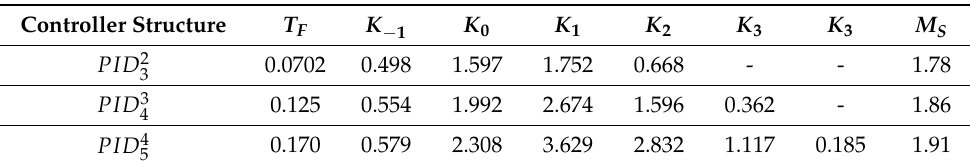
Table 6. The calculated filter time constants T F and controller parameters at different controller orders m ( n = m + 1) for G P 4 ( s ).